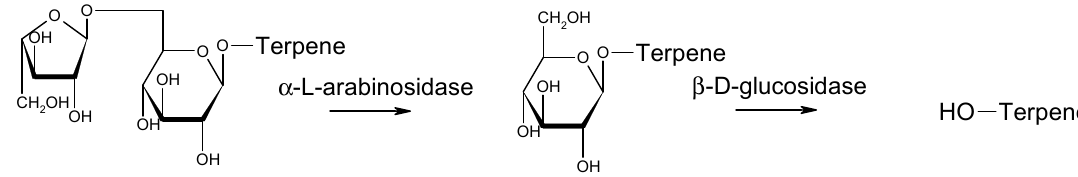
Figure 4. E ff ect of sequential α -arabinofuranosidase and β -D-glucosidase activities on the Figure 4. Effect of sequential α -arabinofuranosidase and β - D - glucosidase activities on the transformation of bonded terpenes into free forms, enhancing the aromatic transformation of bonded terpenes into free forms, enhancing the aromatic profile.